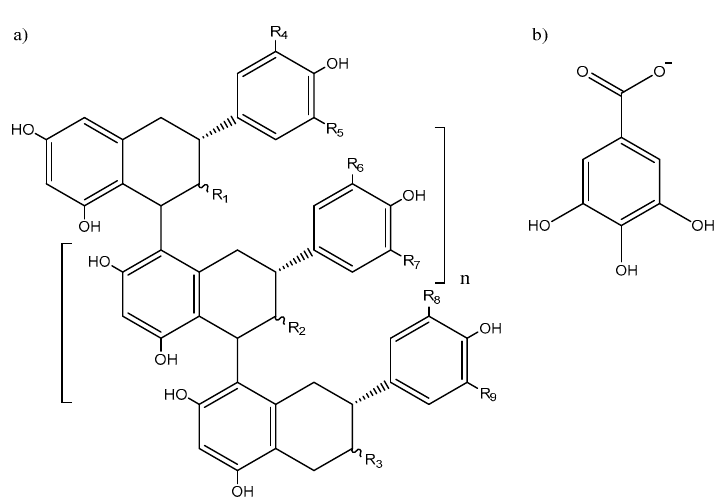
Figure 1. General molecular structure of ( a ) B-type proanthocyanidins (R1, R2, R3 = OH or ( b ) gallate units; R4, R5, R6, R7, R8, R9 = H or OH).